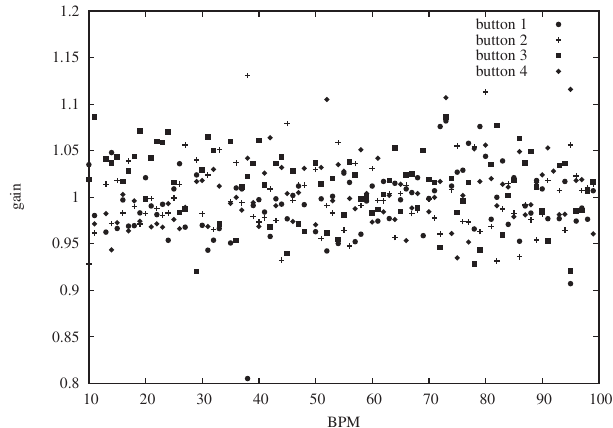
FIG. 11. Fitted gains from a turn-by-turn data set for all 100 beam position monitors, normalized so that the average of the four button gains for each BPM is unity.